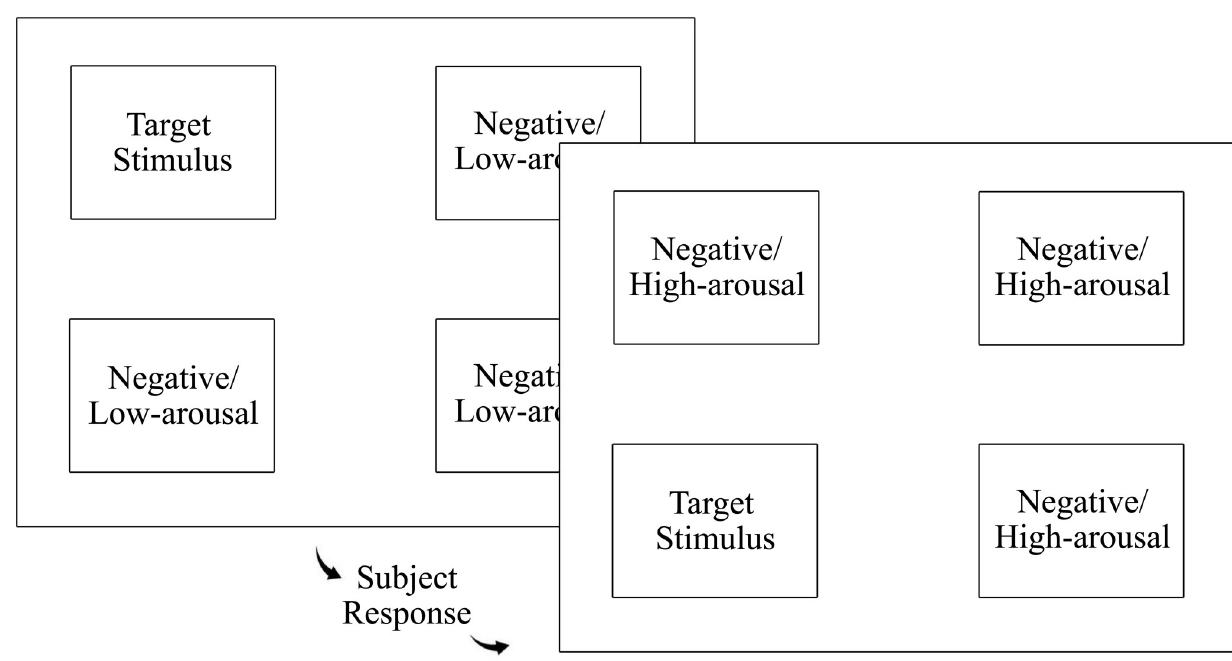
Fig 1. First images displayed in the sustained attention